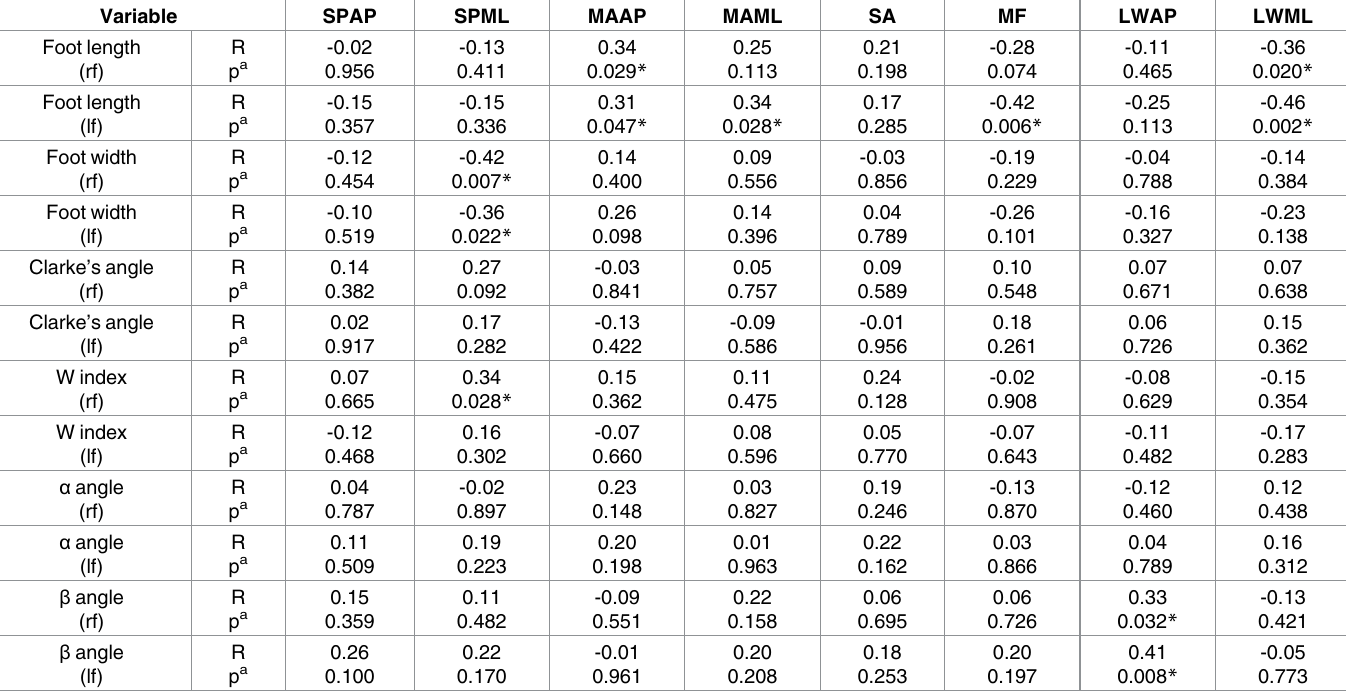
rf, right foot; lf, left foot; SPAP, statokinesiogram path length on the OY axis; SPML, statokinesiogram path length on the OX axis; MAAP, mean COP displacement from the origin on the Y axis; MAML, mean COP displacement from the origin on the X axis; SA, sway area delimited by the COP point; MF, mean frequency of COP displacement, in Hz; LWAP, number of COP displacements along the Y axis; LWML, number of COP displacements along the X axis; R, Spearman’s rank correlation coefficient. a p-values were calculated using the Spearman’s rank